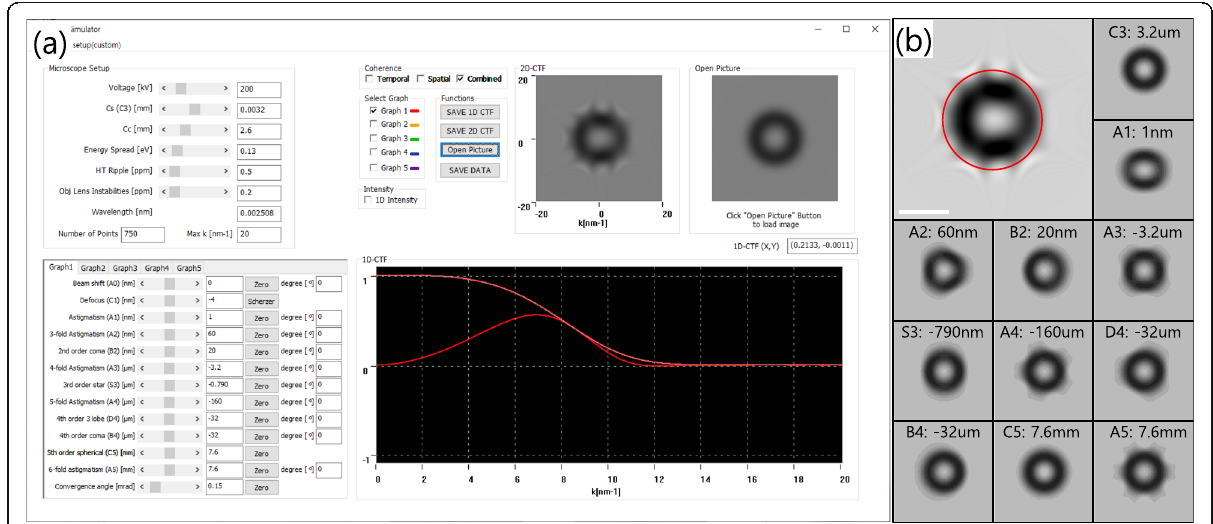
Fig. 3 CTF calculation results with optical aberration parameters required to achieve an information limit of 0.1nm for a TEM operating at 200kV. a Calculation results for 1D-CTF and 2D-CTF with specific instrumental parameters for the AC-TEM and set optical aberration parameters. b Complete and elemental 2D-CTF images obtained using the exCTF simulator. The inset red circle in the complete 2D-CTF image indicates an information limit of